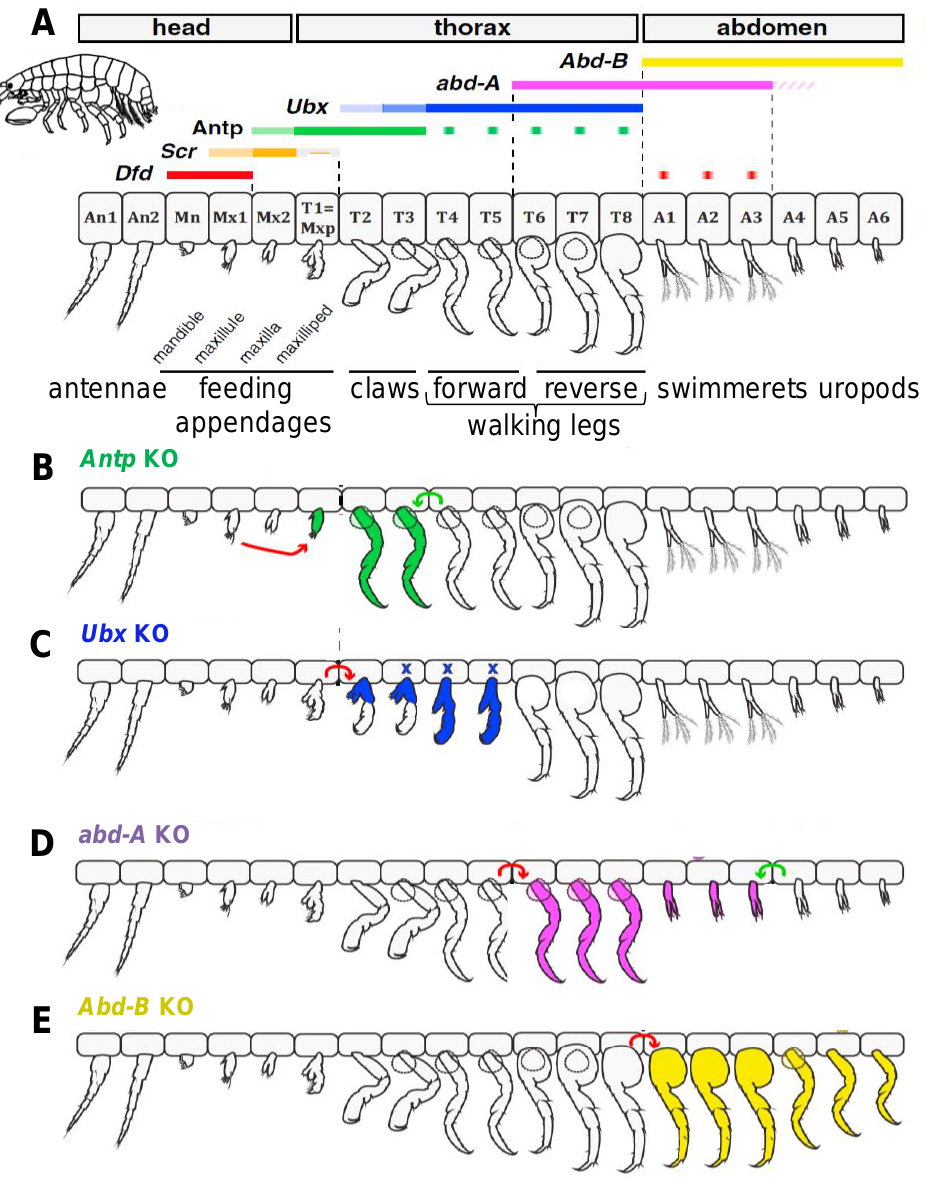
Figure 6. Parhyale Hox gene expression patterns in appendages and their knockout phenotypes. ( A ) normal Hox expressions and appendage phenotypes [17], ( B – E ) Hox gene knockout (KO) appendages: Antp ( B ); Ubx ( C ); abd-A ( D ); Abd-B ( E ). Arrows indicate directionality of the homeotic changes. Reproduced/modified from Martin et al. [54], with permission of Elsevier.